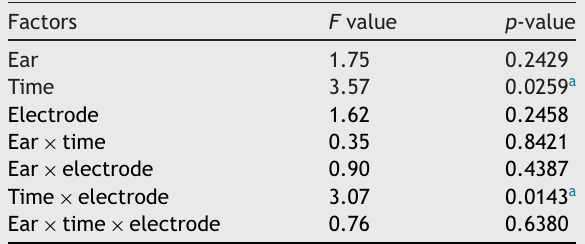
Analysis of variance chart.